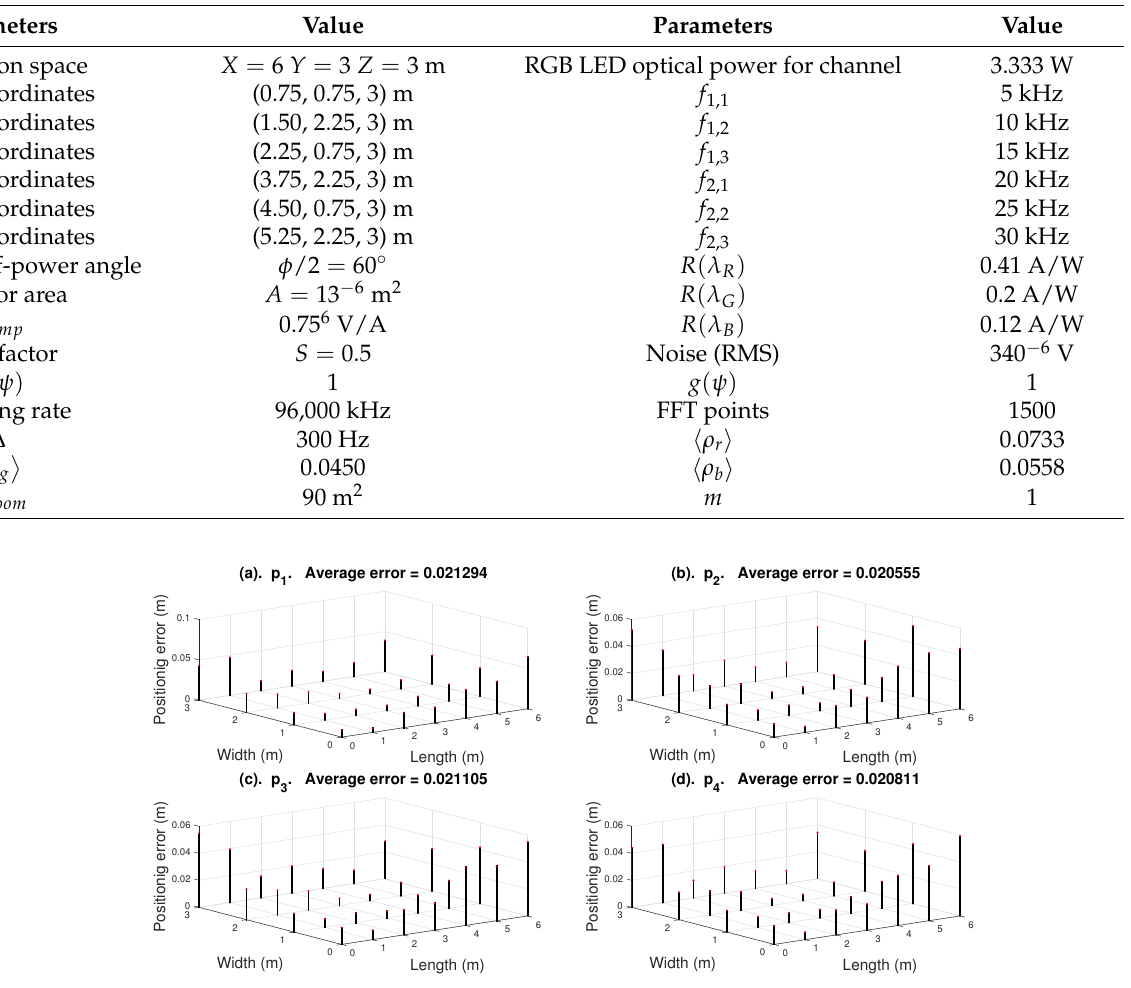
Figure 6. Positioning error for chromatic points p 1 to p 4 .